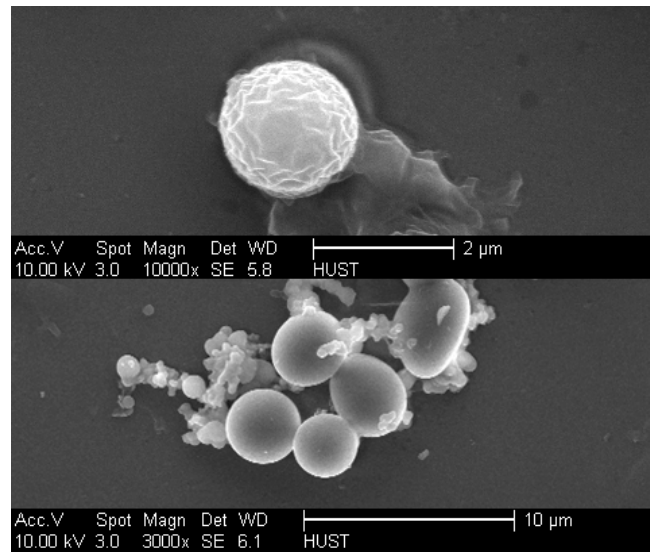
Figure 1. SEM images of the synthesized particles.